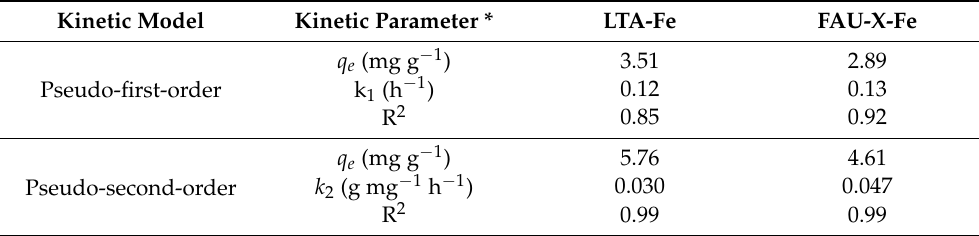
Table 6. Kinetic parameters of phosphate adsorption for LTA-Fe and FAU-X-Fe. Kinetic Model Kinetic Parameter